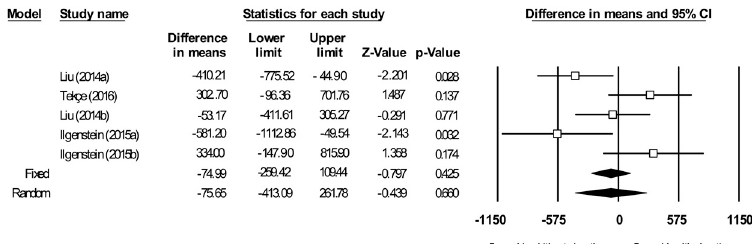
Figure 2. Fracture resistance (Newtons (N)) in indirect restorations with/without elevation of the marginal box. The size of the square represents the weight of each study and the diamond represents the combined results of the meta-analysis. CI is the 95% confidence interval of the mean between a lower and an upper limit.